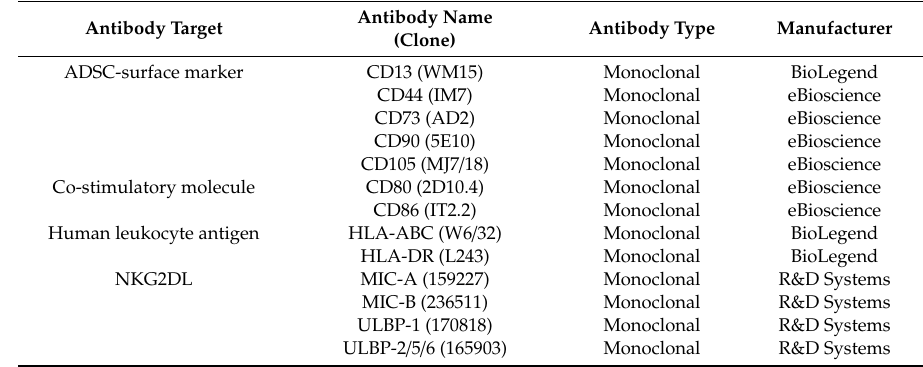
Table 1. Antibodies to surface markers of allogeneic human adipose-derived mesenchymal stem cells (ADSCs) and information about